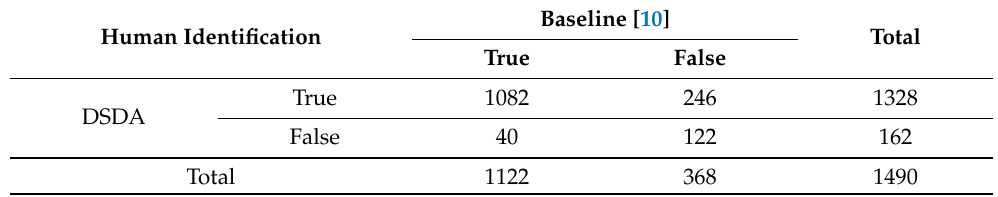
Table 7. Kappa Index Analysis of DSDA on the validation split of